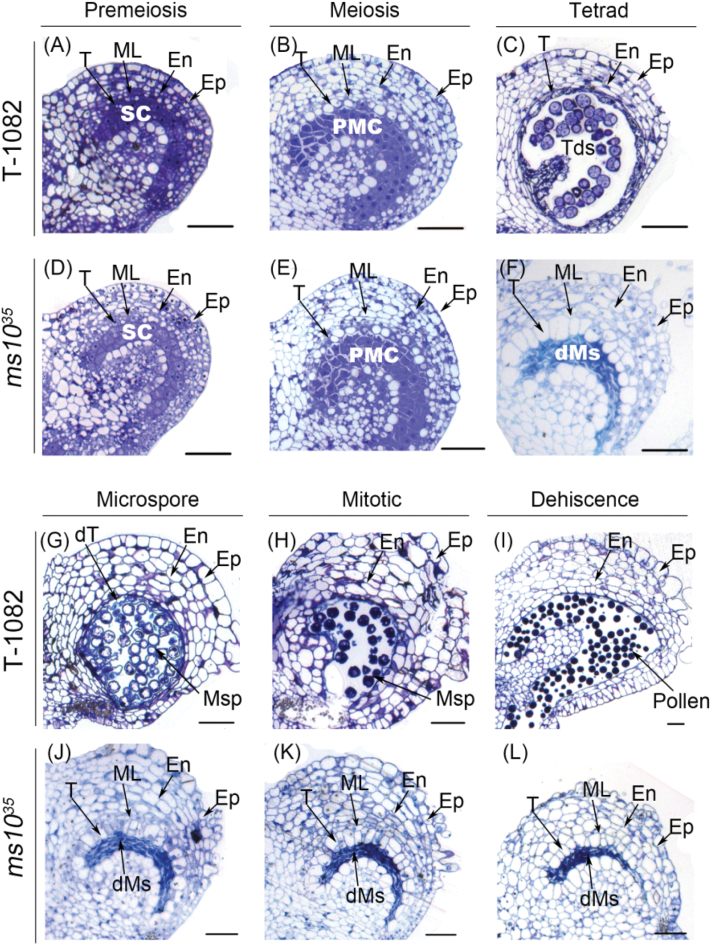
Histological characterization of anther development in T-1082 and ms10
35 flowers. Cross sections of T-1082 (A–C, G–I) and ms10
35 (D–F, J–L) anthers at pre-meiotic (A, D), meiotic (B, E), tetrad (C, F), microspore (G, J), mitotic (H, K), and dehiscence (I, L) stages. dMs, degenerated meiocytes; dT, degenerated tapetum; En, endothecium; Ep, epidermis; ML, middle cell layer; Msp, microspore; PMC, pollen mother cell; SC, sporogenous cell; T, tapetum; Tds, tetrads. Bars, 50 μm. (This figure is available in colour at JXB online.)